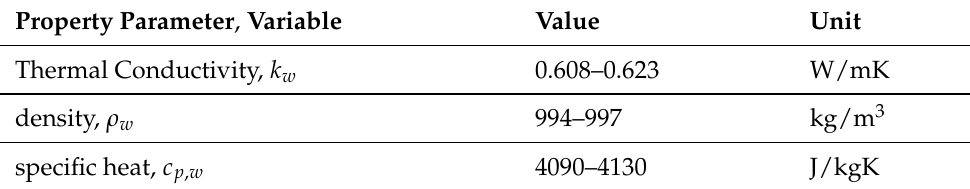
Table 5. Working Fluid Properties: Water.